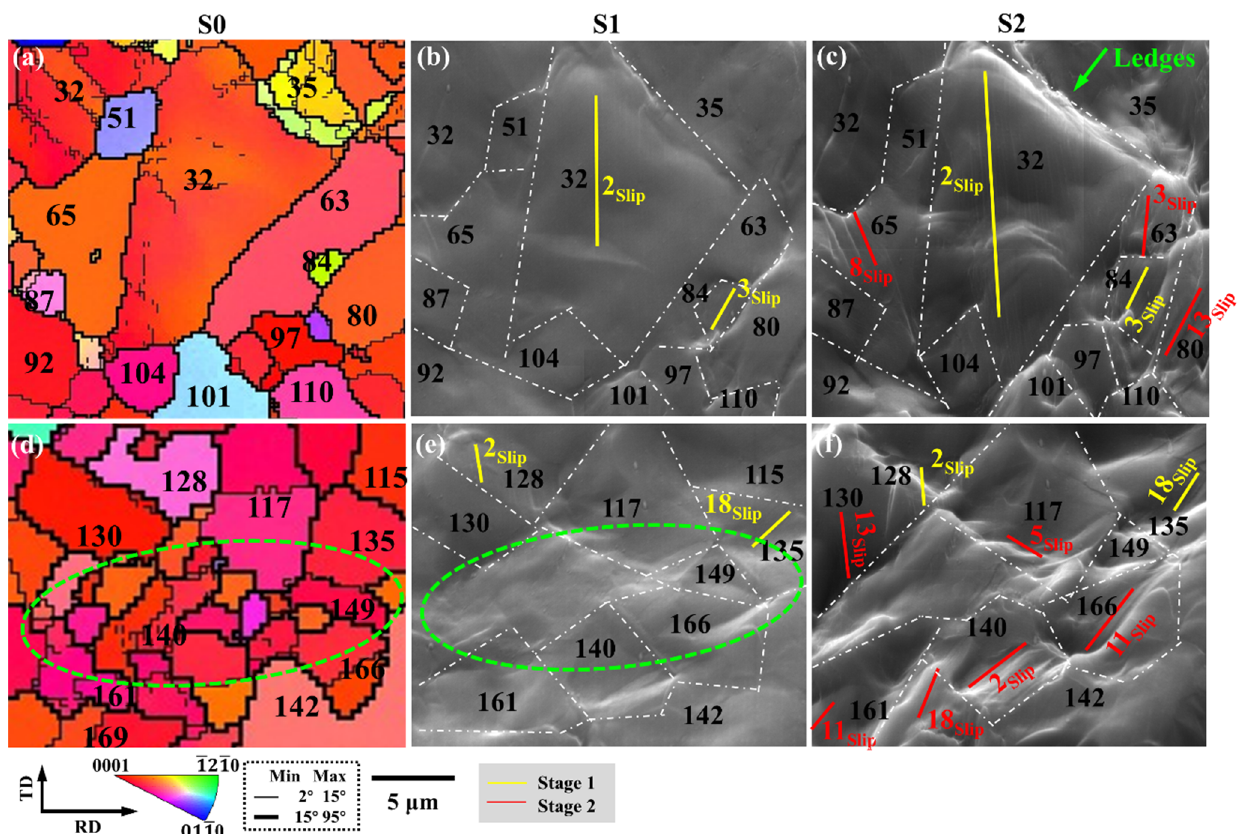
Figure 8. The plastic behavior of large-grained and small-grained regions in slip systems during uniaxial stretching: ( a , d ) IPF images and ( b , c , e , f ) SEM images at different strain stages. The slip system represented by the slip traces in the figure is shown in Figure 7.